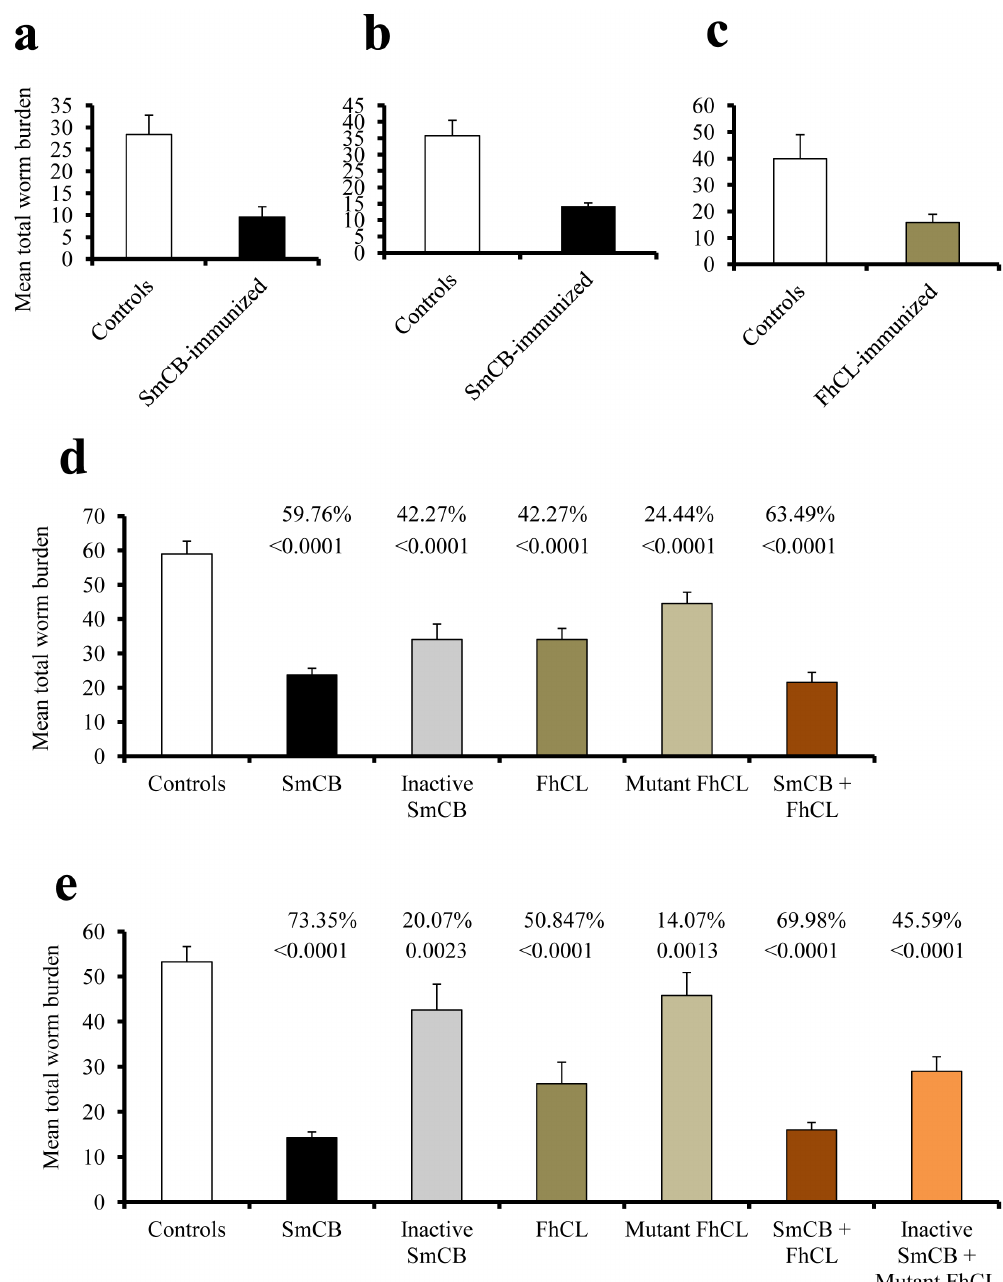
Figure 1. Cysteine peptidases vaccine potential. Mice were immunized 1x (a) or 2x (b–e) with 10 (a–d) or 20 (e) m g active (a–e) or inactive (d,e) cysteine peptidase/mouse/injection, alone (a–e) or in a mixture (d,e), and exposed 15 days later to 120 (a–c) or 140 (d,e) S. mansoni cercariae. Columns represent mean worm burden in 7–14 mice/group, and vertical bars denote SD about the mean. P values and percent reduction in worm burden as compared to control mice are shown above the columns of the test groups. Differences in mean worm burden between mice immunized with active and inactive cysteine peptidases (d,e) are highly significant ( P , 0.0001).